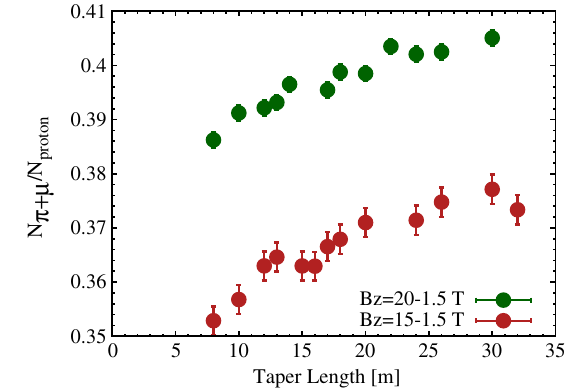
FIG. 6. Number of positively charged muons and pions counted 50 m downstream from the end of the target with a kinetic energy from 80 to 140 MeV plotted vs taper length for target fields of 15 and 20 T.